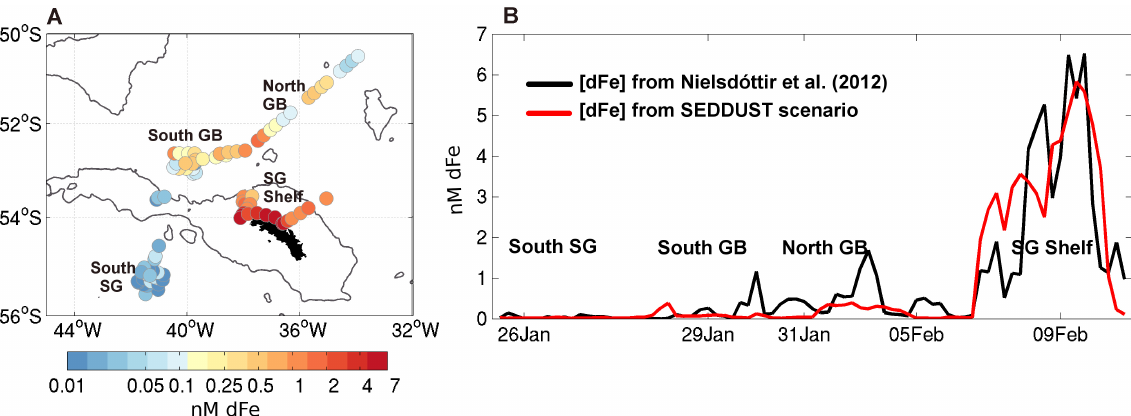
Fig. 7. (A) Location and concentrations of dFe underway measurement from January and February of 2008 (Nielsdóttir et al., 2012). Depth profiles of dFe were taken south of the island in the area denoted as South SG (around 41.24 ◦ W, 55.21 ◦ S) and to the north of the island, in the area denoted as South GB (around 40.10 ◦ W, 52.86 ◦ S). (B) Underway measurement of dFe (red line) and simulated surface dFe concentrations (black line); model values were interpolated onto the dFe sampling locations shown in panel A . For reference, the x axis indicates dates of in situ dFe sampling. The main geographical areas are also indicated and correspond to those marked in panel A .